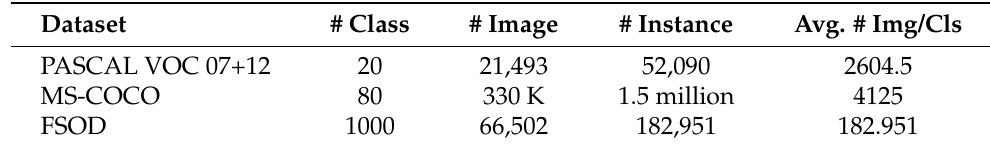
Table 2. Dataset summary for natural images. Generic object detection datasets place emphasis on image diversity, while FSOD datasets focus on category diversity.